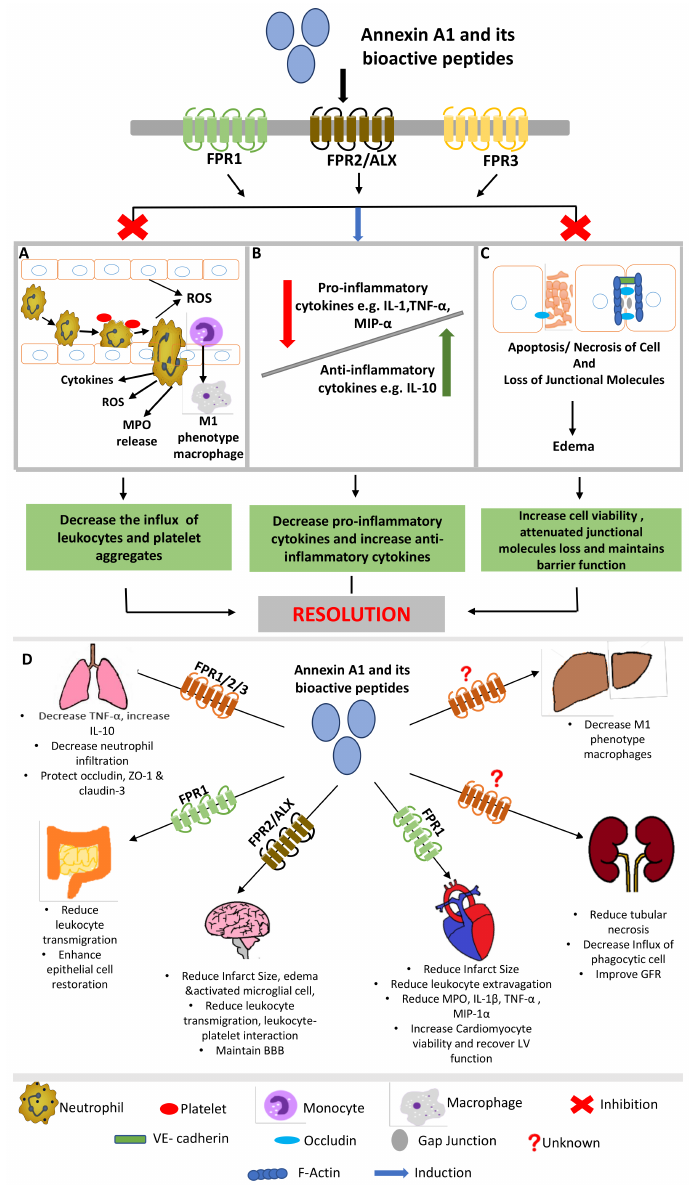
Figure 1. Schematic representation of the protective effects of AnxA1 in I/RI. By binding to members of the FPR family, AnxA1 and its peptide mimetics can ( A ) decrease rolling, adhesion and emigration of leukocytes (monocytes and neutrophils) [31,46,47,53,76,84,88]. In addition, platelet aggregates are diminished [7,31,47] and pro-inflammatory mediators (e.g., myeloperoxidase (MPO), reactive oxygen species (ROS) and cytokines) are moderated [88,90]. ( B ) AnxA1 promotes the balance between pro-inflammatory [7,31,47,58,60,88,90] and anti-inflammatory cytokines, thereby fostering homeostasis in the host. ( C ) The disruption of barrier function, due to the loss of junctional molecules and apoptosis/necrosis of endothelial/epithelial cells, is one of the main characteristics of I/RI. AnxA1 has a positive effect on maintaining barrier function [49] and reducing edema [48] by inhibiting the loss of junction molecules, in particular occludin, VE-cadherin and actin cytoskeleton [50,59]. Thus, AnxA1 regulates the inflammatory responses elicited during I/RI leading to the resolution of inflammation and decreased tissue injury in ( D ) different vascular